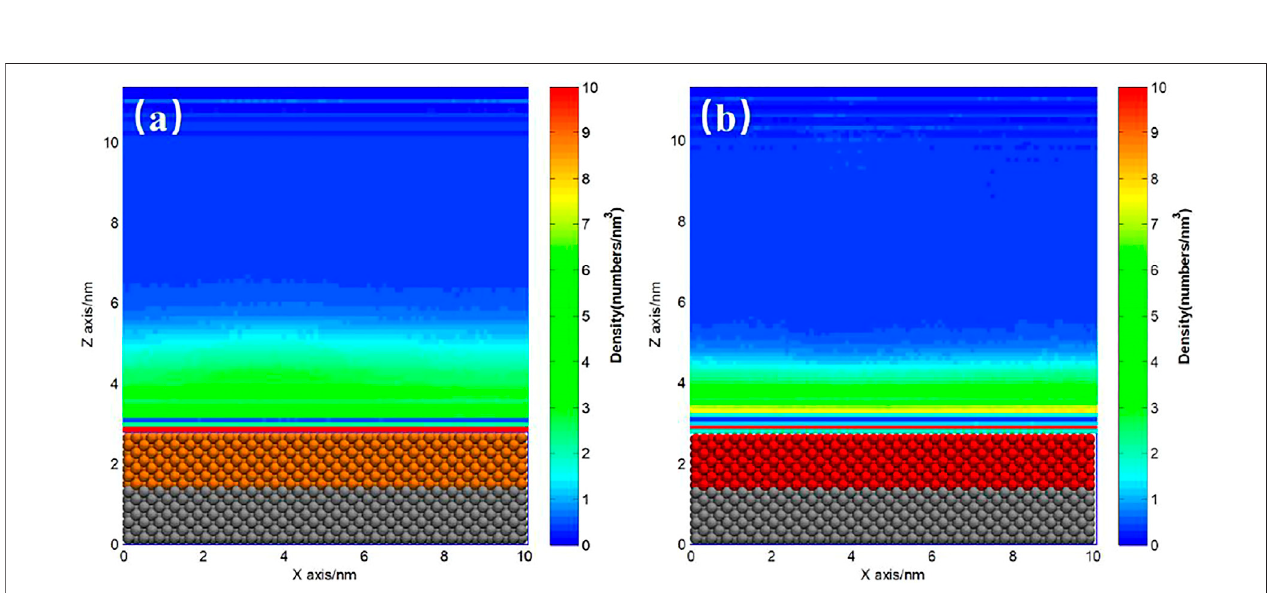
FIGURE 3 | Time-averaged gas density distribution color maps (20 – 120 ns). (A) S M surface, (B) S H surface. The DGL pro fi le were seen on both S M and S H substrates.